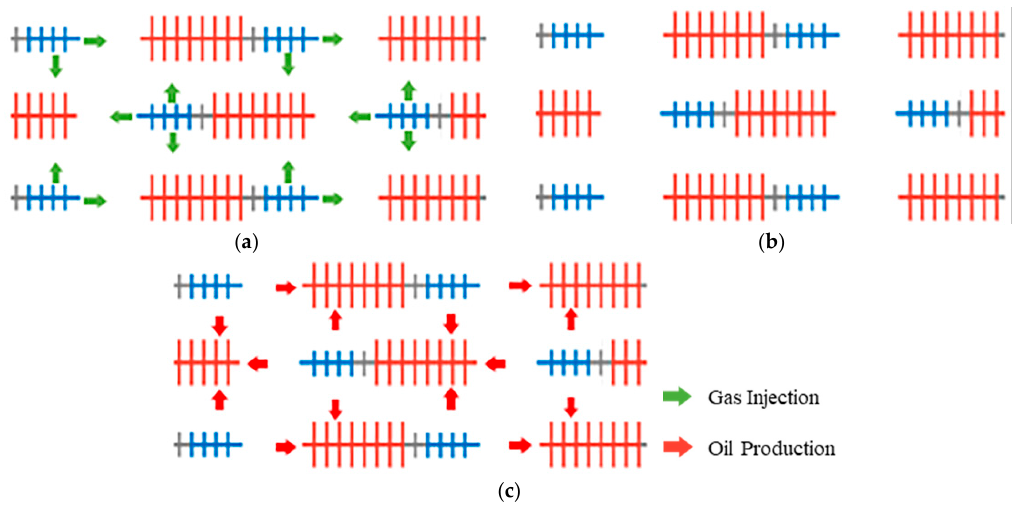
Figure 2. Sketch of Allied In-Situ Injection and Production Technology (AIIP).